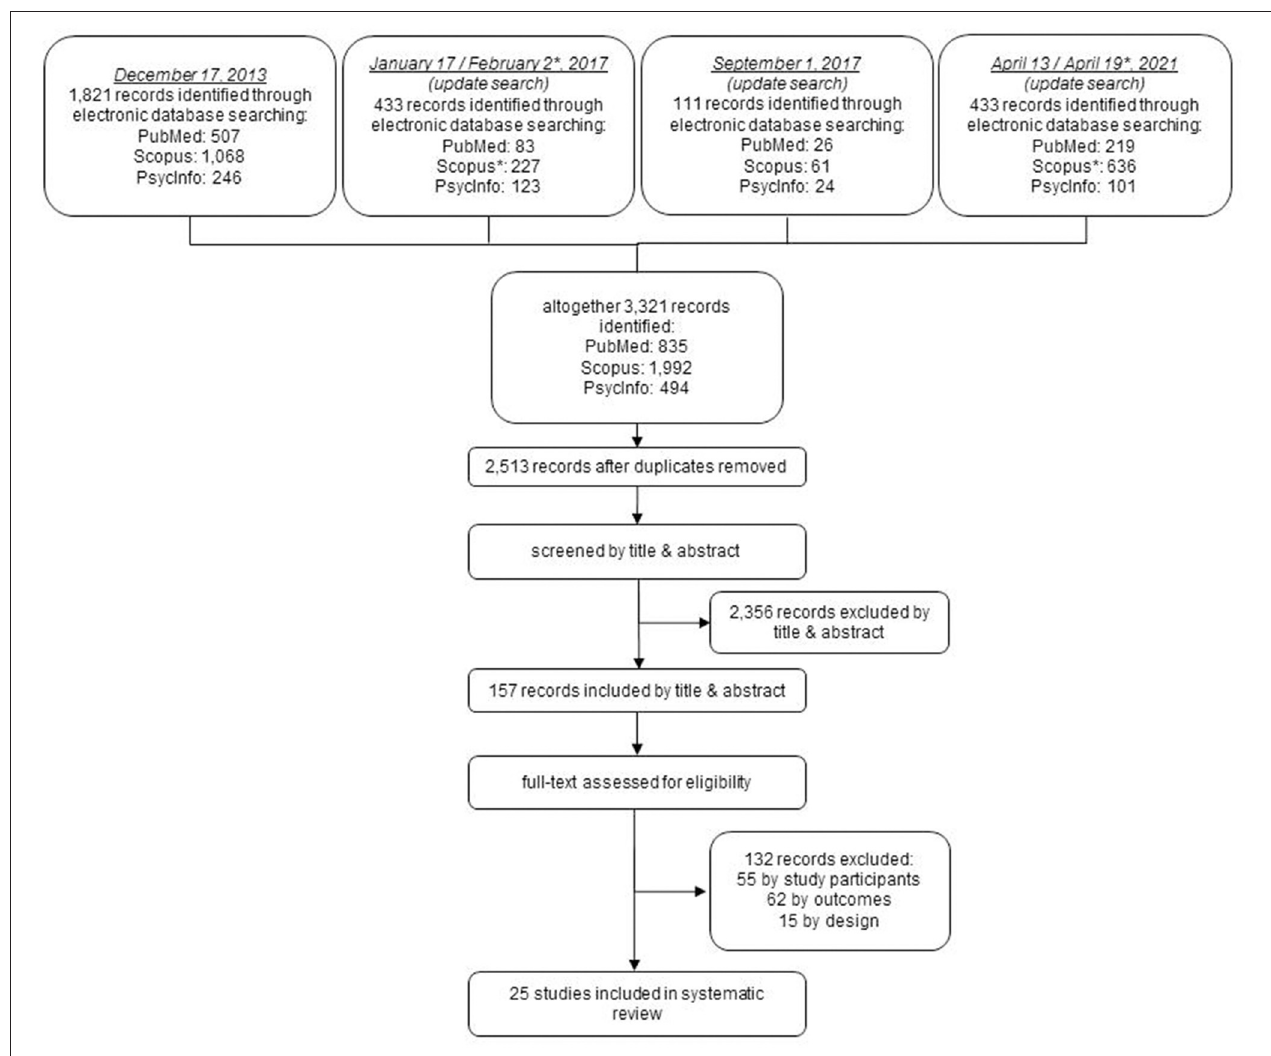
FIGURE 1 | Flowchart of results of the